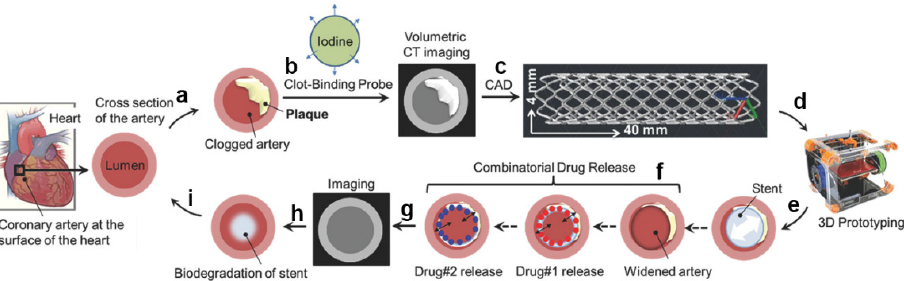
Figure 4. Stepwise process for developing a personalized coronary stent. ( a ) Cross-section of the artery shown at the surface of the heart, plaque buildup is shown inside the lumen due to various factors, e.g., aging, diet, genetics; ( b ) a clot-binding probe, i.e., a fibrin-targeted iodinated CT contrast probe is administered to locate the blood clot. At the same time, volumetric CT imaging helps to get an accurate measurement of the blockage; ( c ) the imaging information is transferred to a computer- aided design (CAD) software to design a personalized stent; ( d ) a PCL-GR polymer composite is used for fused deposition modeling additive manufacturing technique in a commercial 3D printing machine; ( e ) the prototyped stent is placed inside the artery; ( f ) the incorporation of two drugs for sequential release; ( g ) the healing process is further monitored by CT imaging; ( h,i ) the polymer gets biodegraded inside a widened